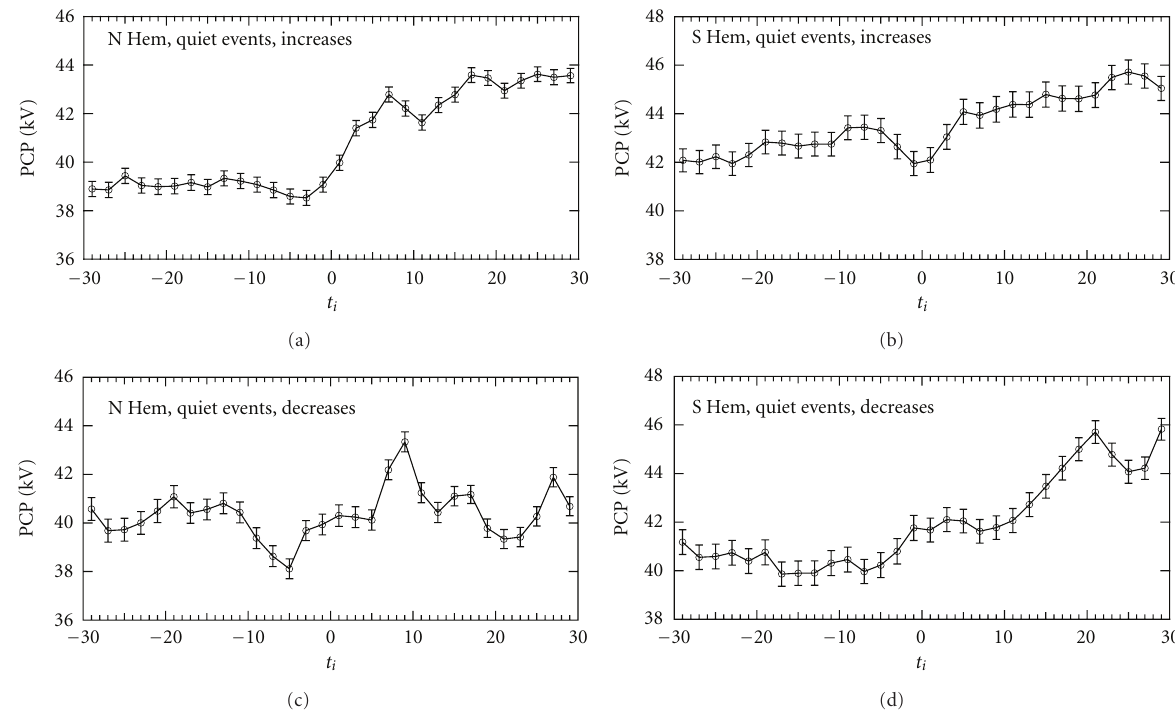
Figure 3: V av ( i ) (PCP) as a function of the scan time, t i , for Quiet events: (a) NH Is; (b) SH Is; (c) NH Ds; (d) SH Ds.